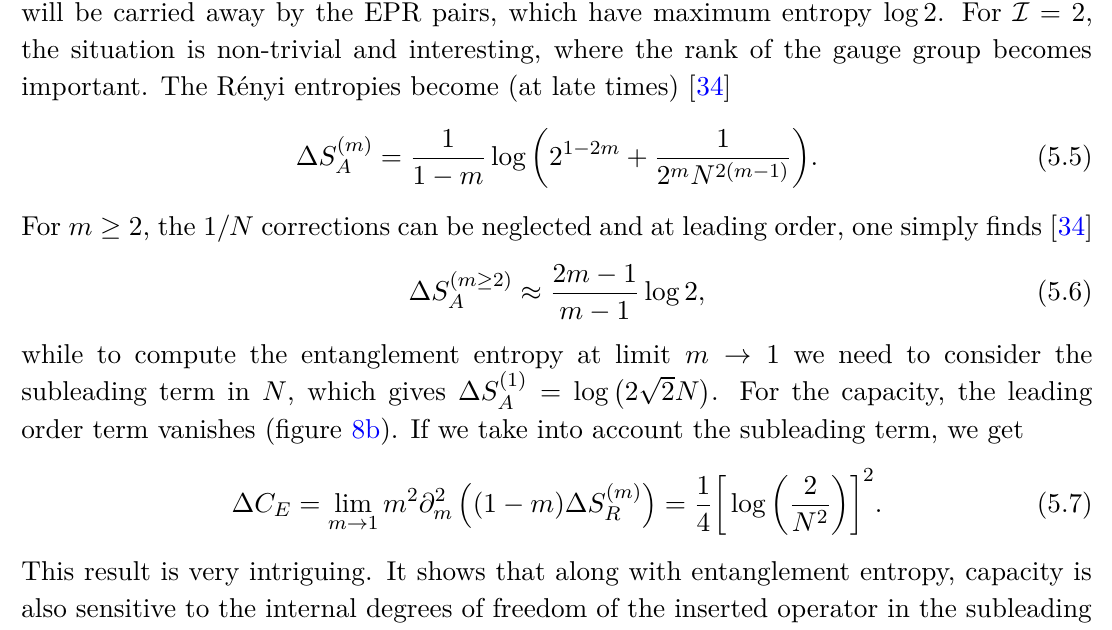
Figure 9. Plot of (a) ∆ S (2) and (b) ∆ C E for I = 3 . Here we choose L = 10 . At t ≈ 26 . 3257 , A capacity reaches a peak where the “Page transition” occurs and dies off at late times. ∆ S (2) saturates to 5 log 2 . These plots are again closely similar to the entanglement entropy and capacity plots in the EoW brane model (microcanonical ensemble)